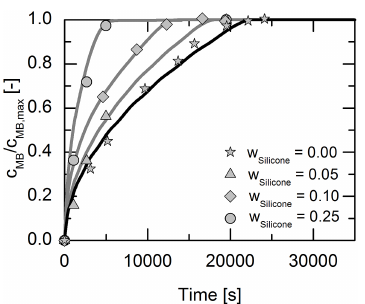
Figure 13. MB concentration profiles in PVA/silicone composite films of 170µm thickness at 298.15K and 90% RH for silicone mass fractions of 0.00, 0.05, 0.10 and 0.25. Symbols are experi- mental data and lines are modeled profiles using oxygen diffusion coefficients from Table 2. Gray lines show the modeling for films with silicone particles and the black line is the modeling for a film in absence of